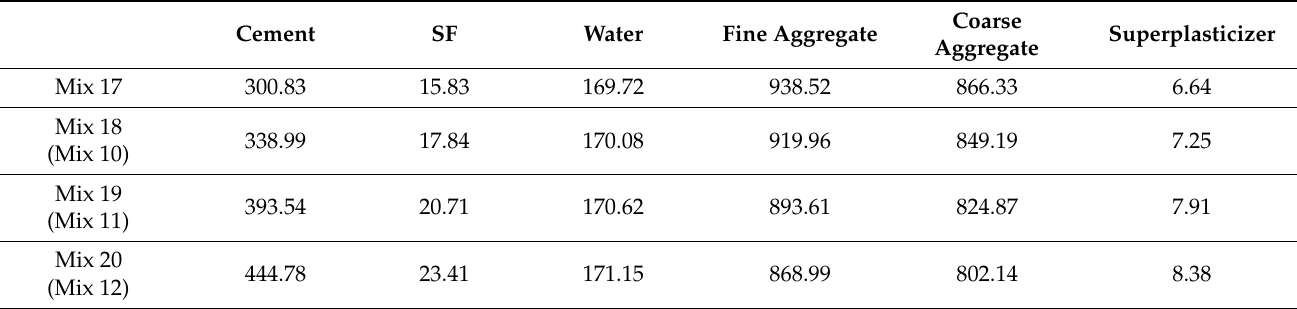
Table 13. Optimal design mixtures for Case 5: low-total-cost concrete with global warming (unit: kg/m 3